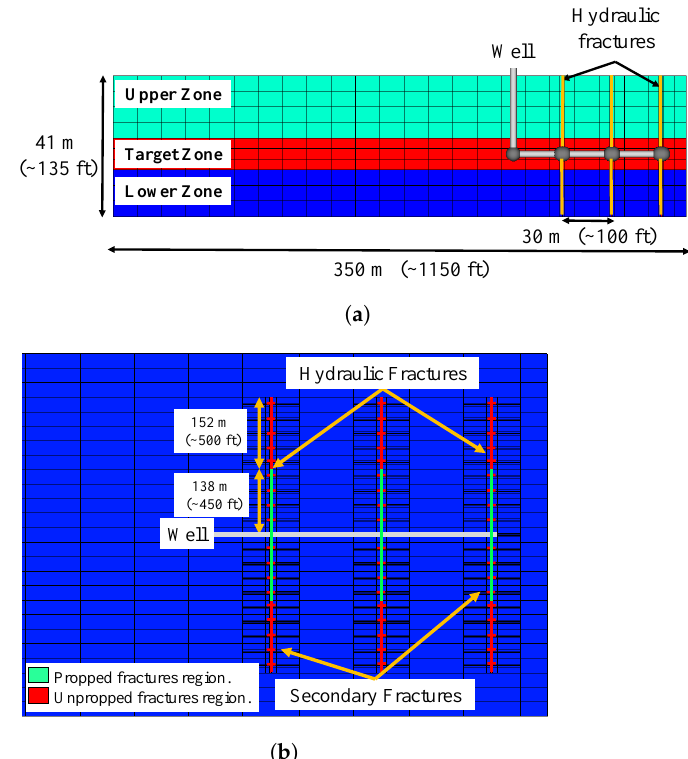
Figure 5. Reference numerical simulation model. ( a ) Cross-view of the model along the wellbore and ( b ) map view of the